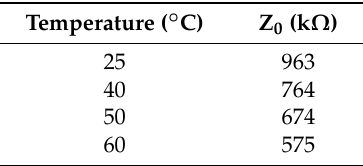
Table 5. Impedance values of SWP700-10% PVP sensor at different temperature under dry air.